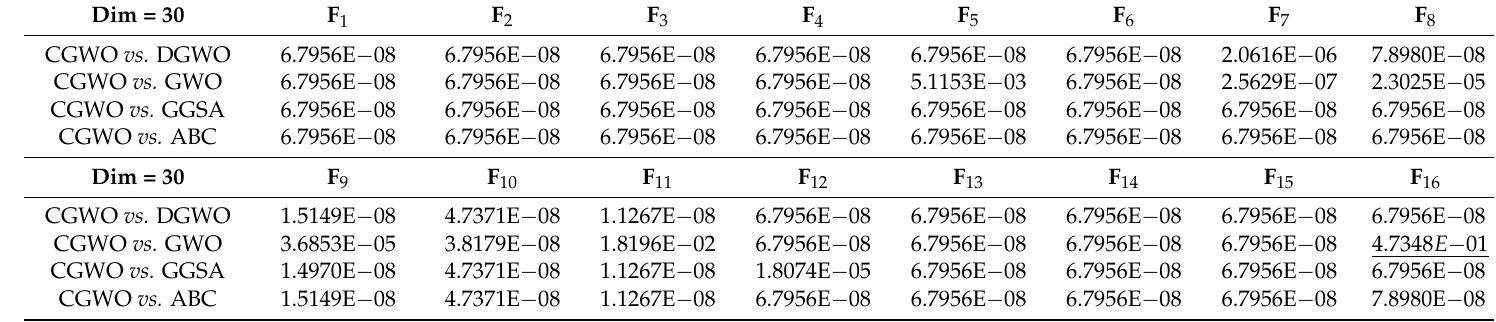
Table 7. p -values produced by Wilcoxon rank-sum test comparing CGWO vs. DGWO, GWO, GGSA, and ABC at Dim = 30 ( p ě 0.05 have been underlined). Dim =